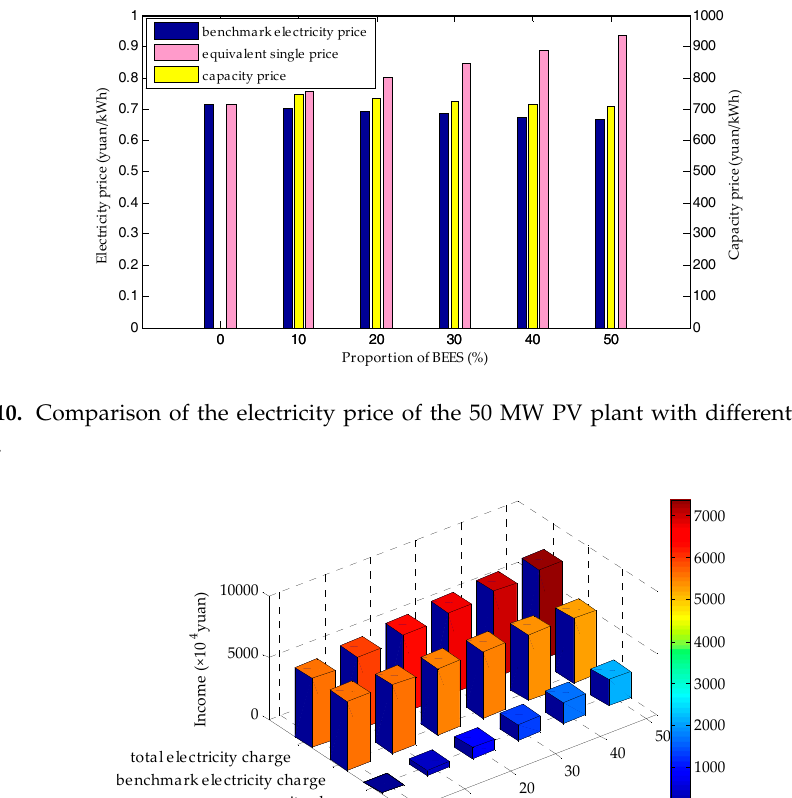
total electricity charge